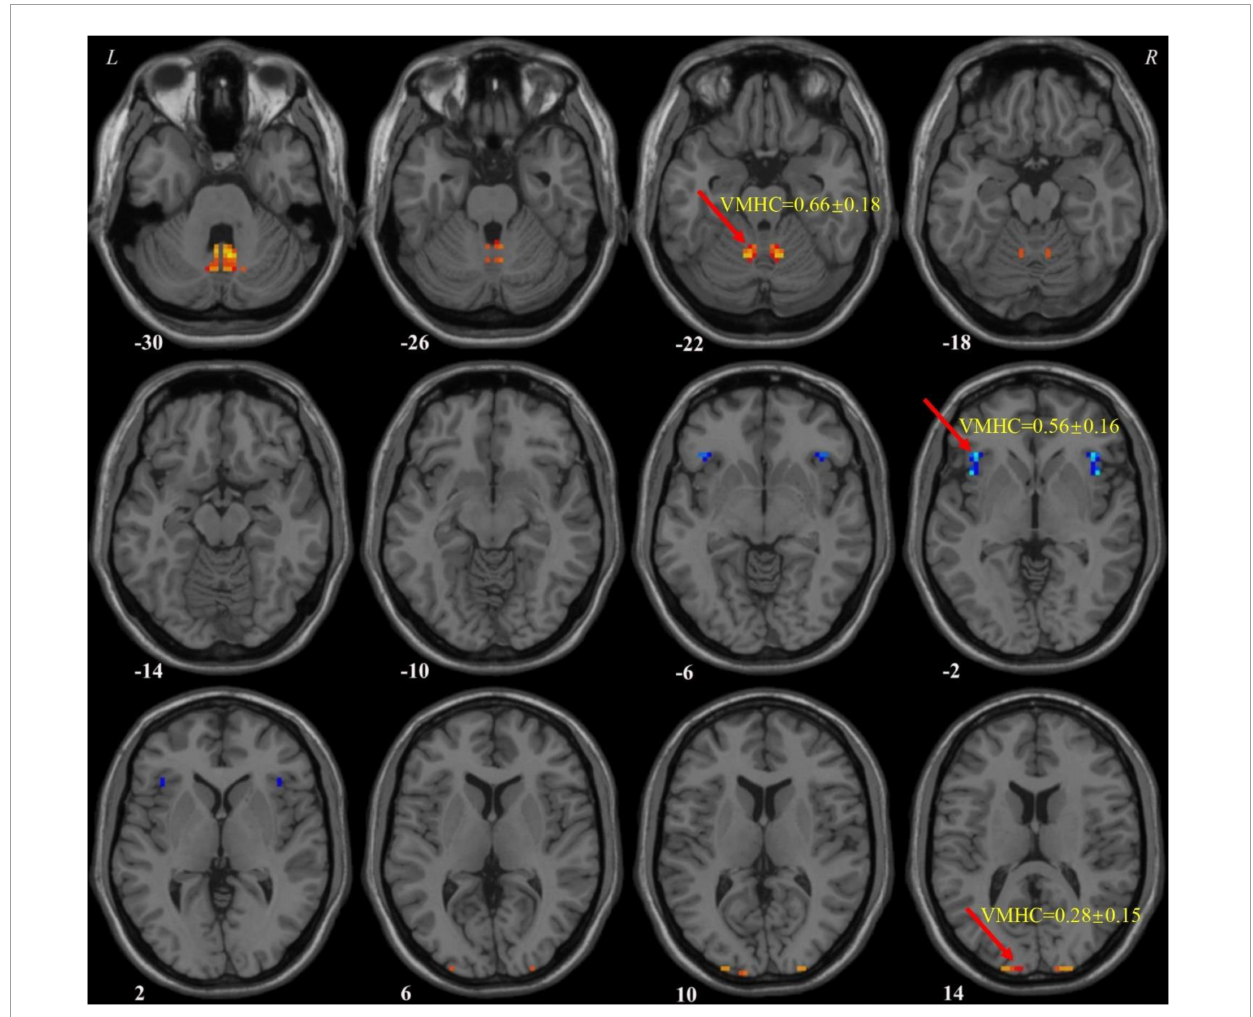
FIGURE1 Voxel-mirrored homotopic connectivity (VMHC) values of abnormal regions in patients with MDD. MDD, major depressive disorder; VMHC, voxel-mirrored homotopic connectivity.